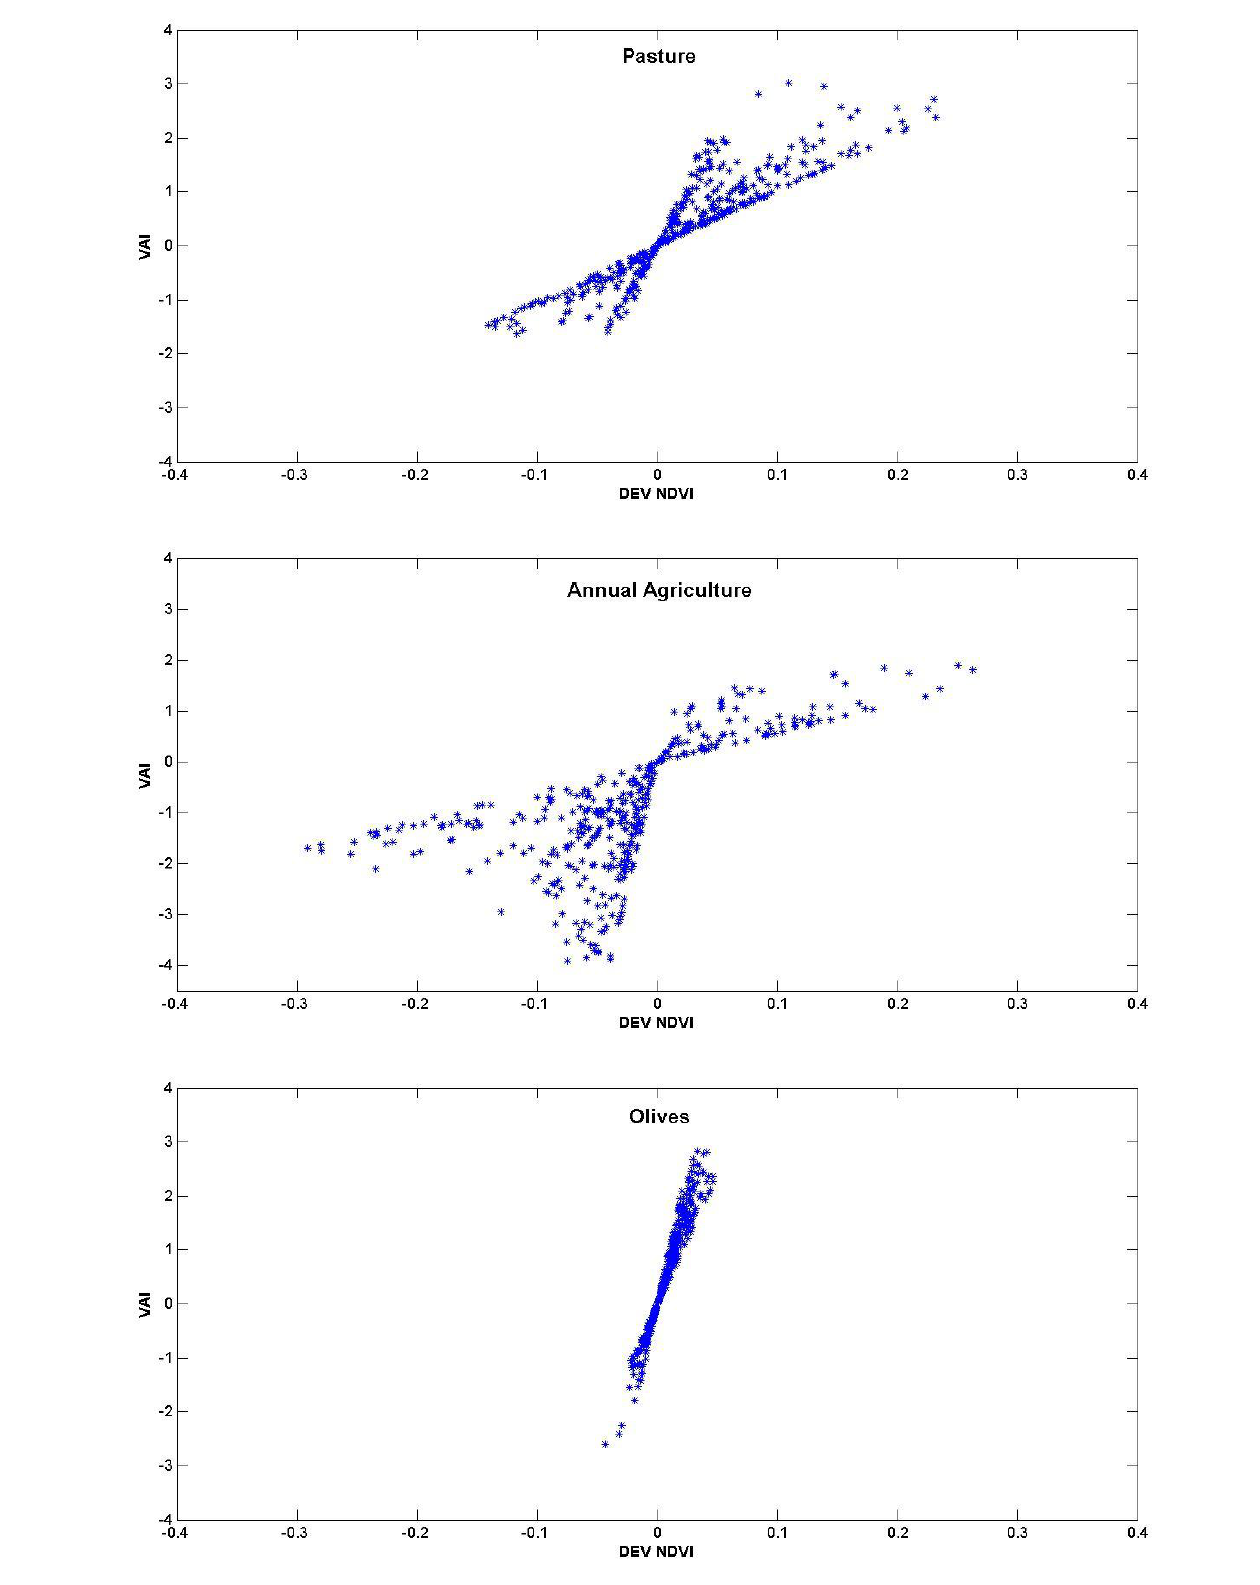
Figure 6. Intercomparison between VAI and DEV.NDVI indexes, estimated from the full set of database recordings corresponding to the rainy season months